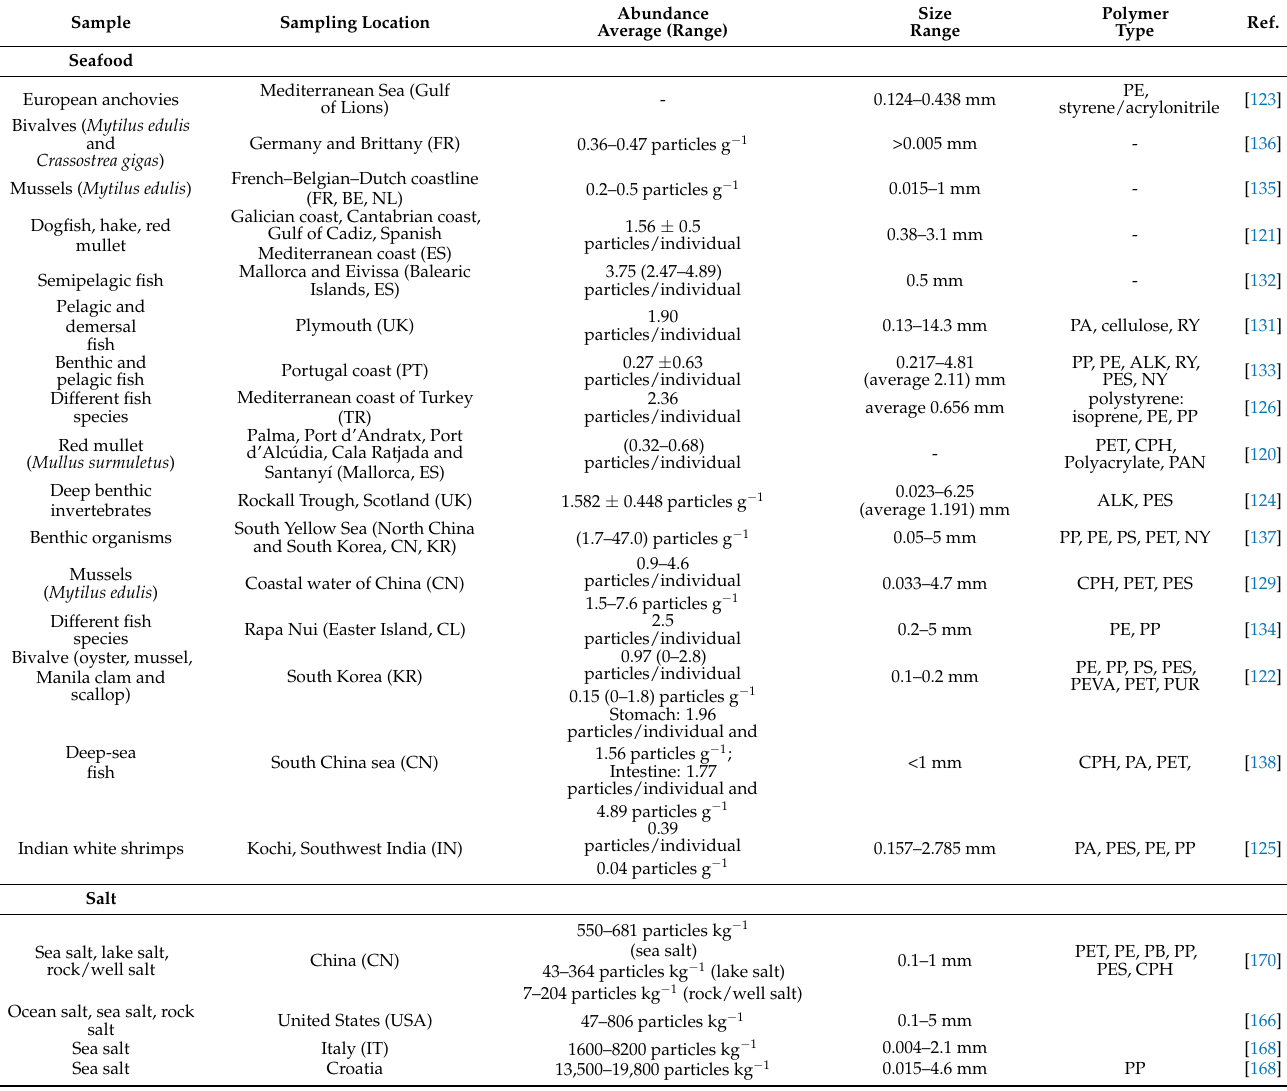
Table 1. Occurrence and quantification of microplastics in foods and